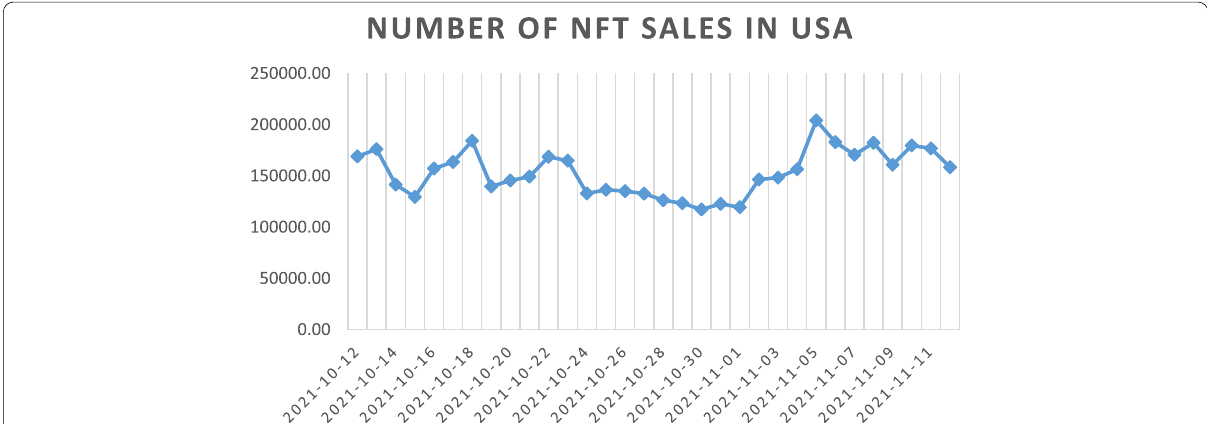
Fig. 5 There was an increase in the diffusion of the metaverse-related technology, expressed in the number of NFT sales in the USA, after the hype was initiated on October 28, 2021 [137]